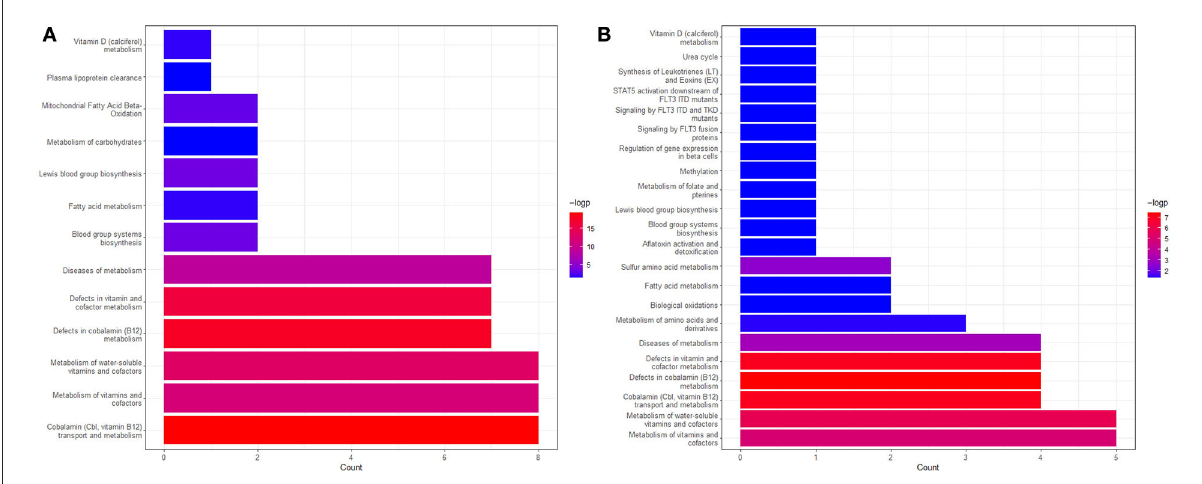
FIGURE8 The Reactome enrichment analyses genes associated with vitamin B12 (A) and Hcy (B) . The pathways with adjusted P < 0.05 are left in the figure. More information can be found on the website (https://reactome.org/).